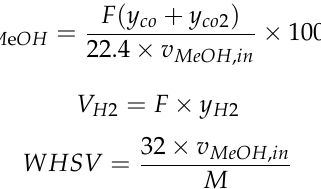
Figure 7. Thermoelectric modules’ (1) to (5) hot and cold side temperature distribution along the flow direction.